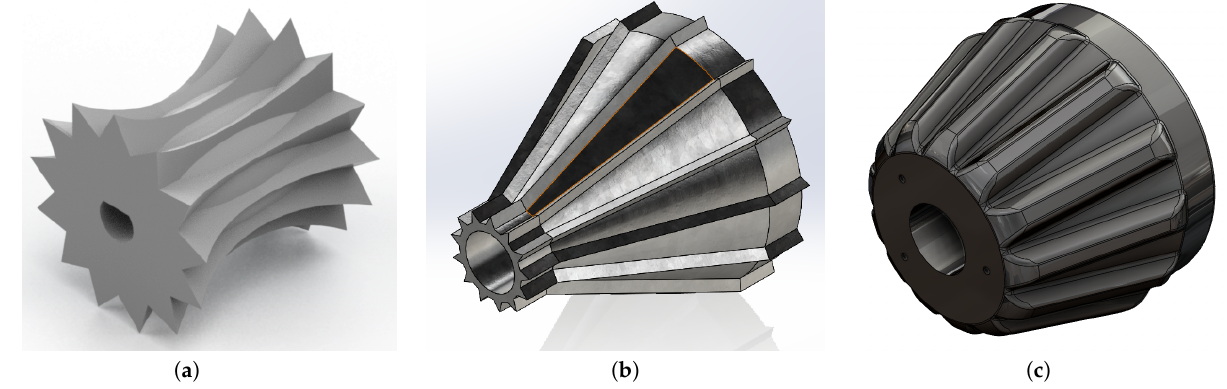
Figure 2. Geared friction wheel design concepts: ( a ) first wheel attempt, ( b ) idealized conic wheel and ( c ) final wheel (left to right by order of appearance).